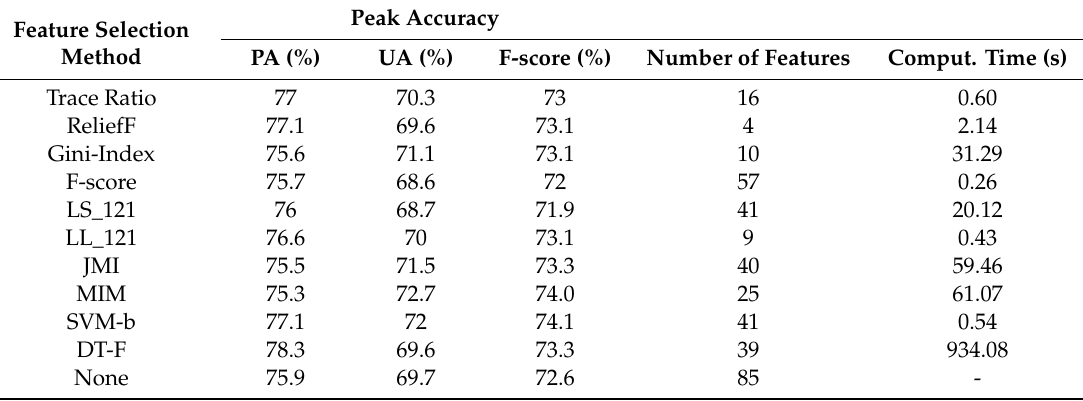
Table 4. F-score, PA and UA of Parthenium weed using optimal feature subsets yielded by investigated feature selection methods for the second training